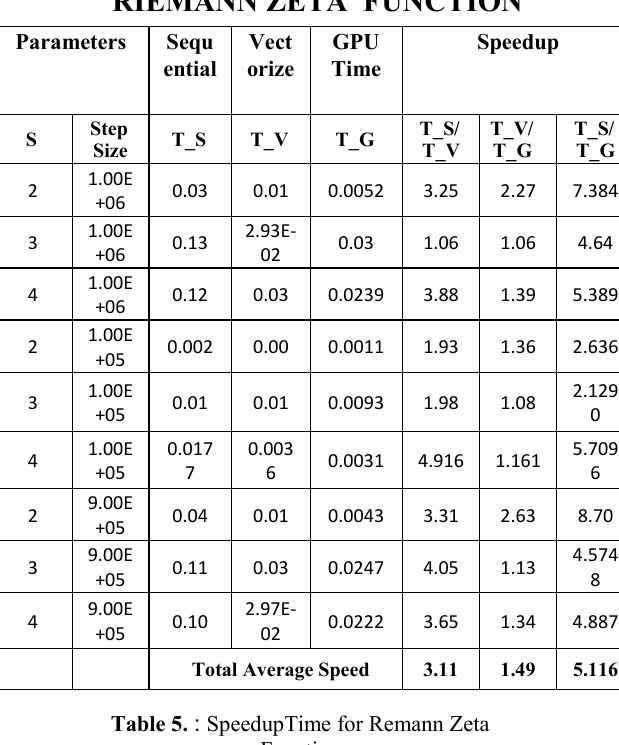
Table 5. : SpeedupTime for Remann Zeta